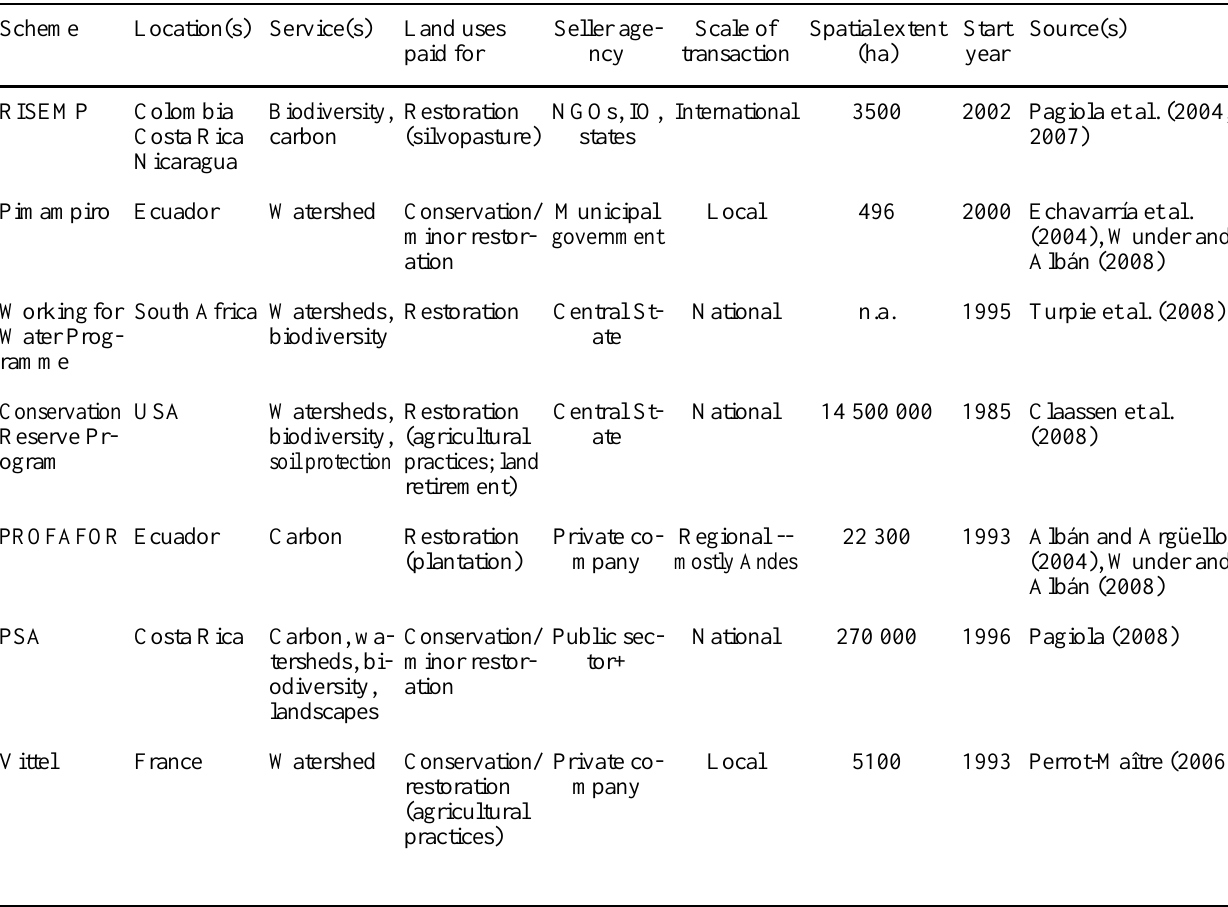
Table 1. Examples of PES-type experiences worldwide (RISEMP = Regional Integrated Silvopastoral Ecosystem Management Project; NGO = non-governmental organization; IO = international organization; n.a. = not